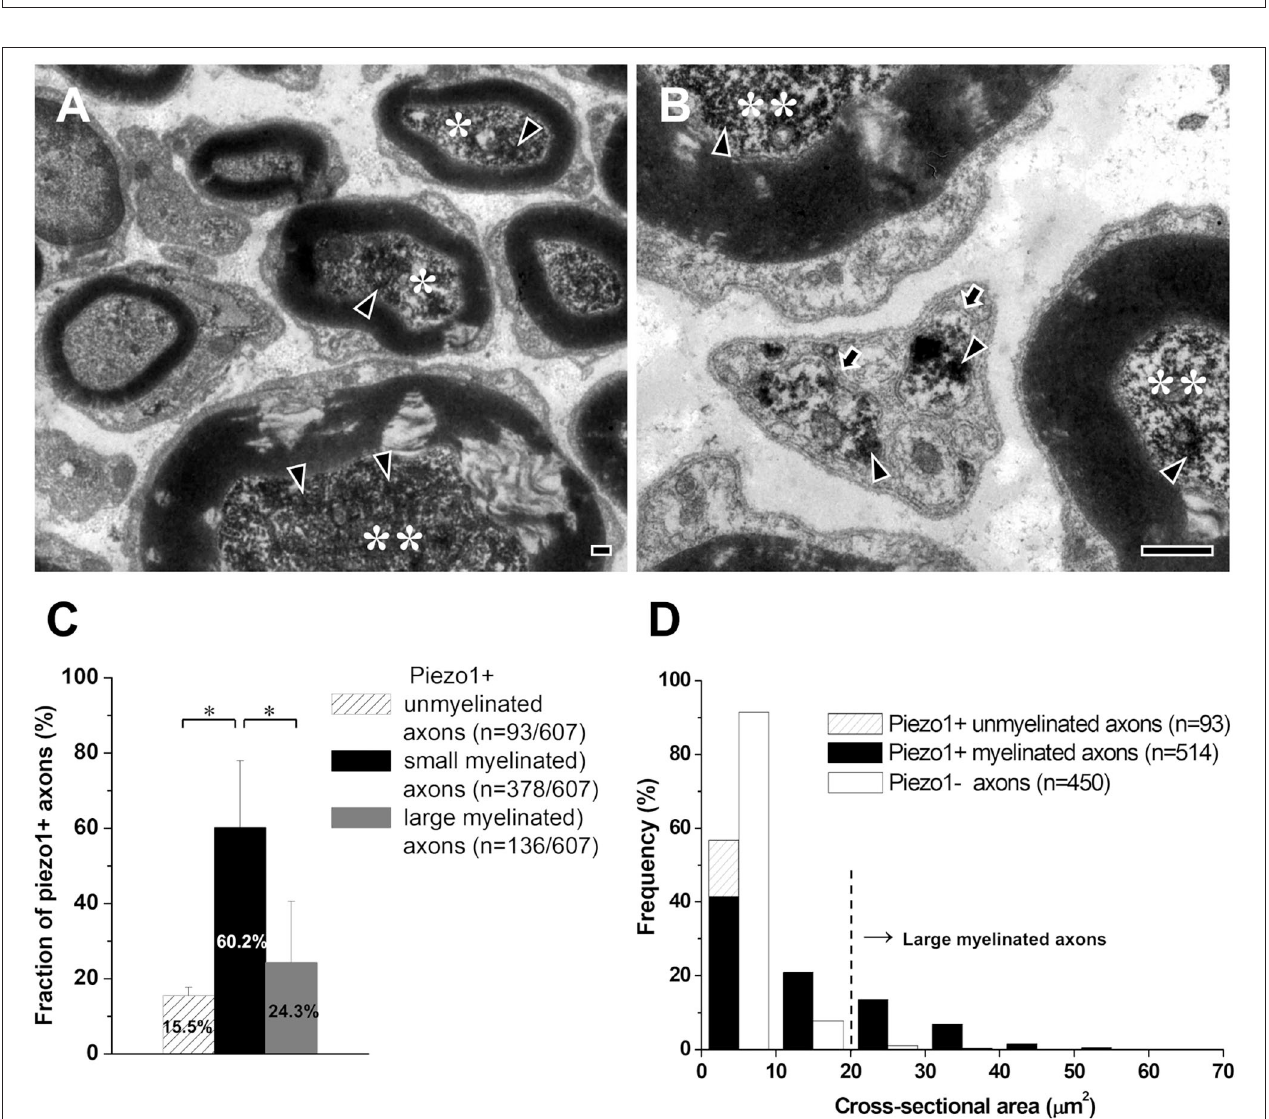
FIGURE 1 | and the human dental pulp (C,D) . The Piezo1 immunostaining in the TG neurons and pulpal axons is completely abolished by preadsorption with the corresponding blocking peptide, confirming the specificity of the Piezo1 antibody. (E,F) Light micrograph showing Piezo1 + neurons in the TG (E) and their size distribution (F) . Piezo1 is expressed mostly in medium-sized and large neurons. (G-L) Double immunofluorescent staining for Piezo1 and CGRP (G) , IB4 (H) , or NF200 (I) , and the quantitative analysis of colocalization of Piezo1 and CGRP (J) , IB4 (K) , or NF200 (L) . Piezo1 + neurons frequently co-stain NF200 but seldomly for